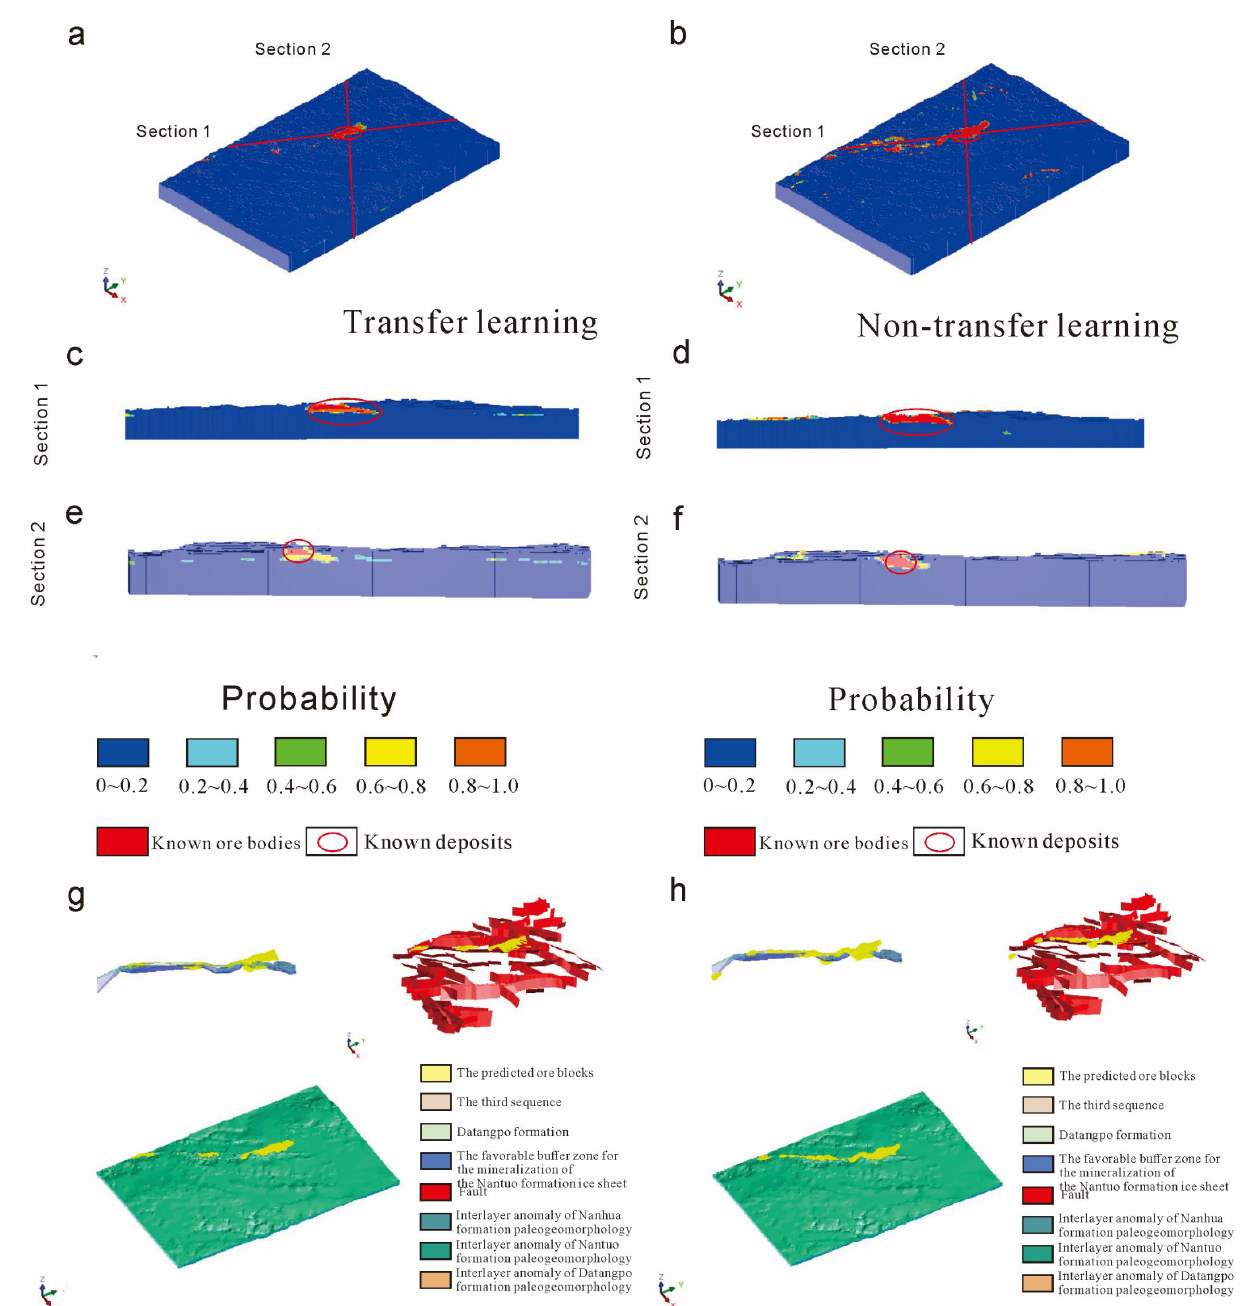
Figure 17. The result comparison of 3D metallogenic prospect delineation in test 6. ( a , c , e ) show the prediction results of the 3D CNN-TL model; ( b , d , f ) show the prediction results of the 3D CNN. ( g ) is the target section delineated by the 3D CNN-TL prediction model when the threshold value of the metallogenic prospect is 0.65, and ( h ) is the target section delineated by the 3D CNN model. To sum up, ore-controlling factors of 1–6 are superior, while those of 1–12 in the fault layers significantly affect the learning results. The 3D CNN model performs well with no